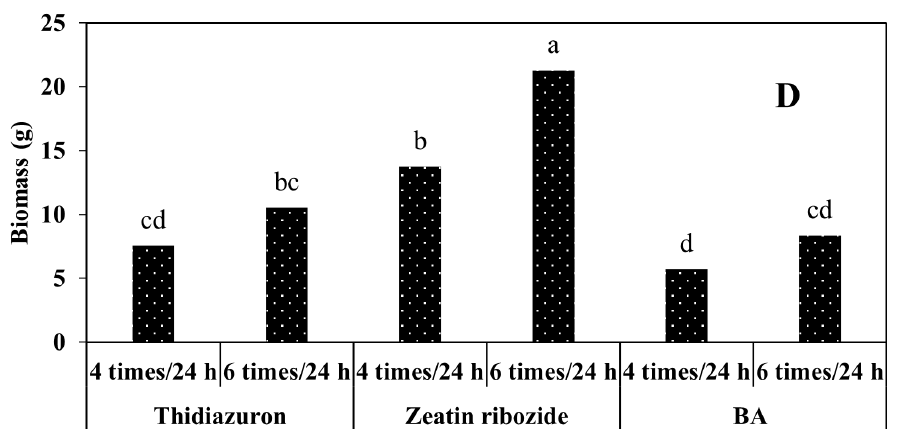
Figure 8. Mean comparison of the number of stems ( A ), the length of the longest stem ( B ), multi- plication rate ( C ), and biomass ( D ) of S. pennata seedlings under the effect of plant growth hor- mones and the number of feeding cycles using the temporary immersion bioreactors system. Bars common letter do not differ significantly from each other. p < 0.01 probability level (Duncan’s test). with a common letter do not differ significantly from each other . p < 0.01 probability level (Dun- can’s test).